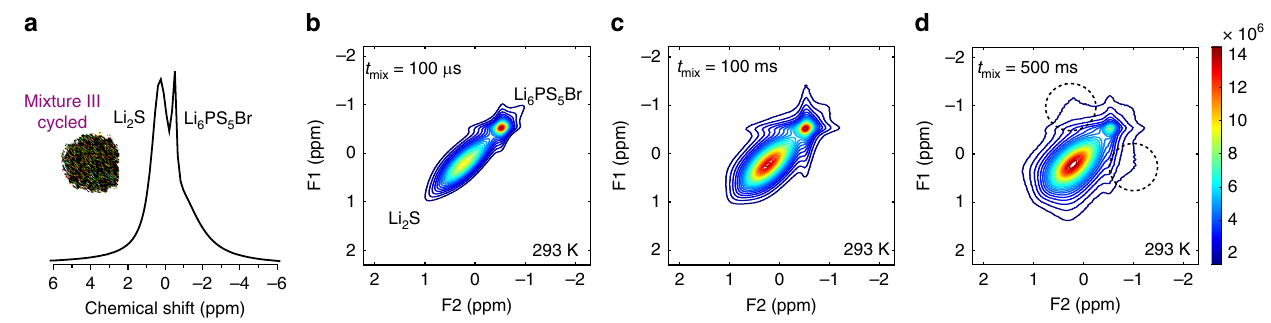
Fig. 3 NMR measuring the spontaneous lithium-ion transport between the Li 6 PS 5 Br solid electrolyte and the Li 2 S cathode after cycling. a One-dimensional (1D) 7 Li magic angle spinning (MAS) spectrum of the cycled Li 6 PS 5 Br – Li 2 S cathode mixture III. b – d Two-dimensional 7 Li – 7 Li exchange spectra (2D-EXSY) measured under MAS at a resonance frequency of 330.39 MHz and spinning speed of 30 kHz at 298K for the cycled mixture III at b t mix = 100 µ s, c t mix = 100 ms, and d t mix = 500 ms. Only after t mix = 500 ms, off-diagonal exchange intensity is observed re fl ecting the lithium-ion exchange from Li 2 S